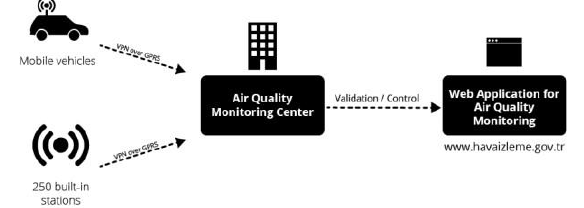
Figure 1. Architecture for Turkish AQ Monitoring